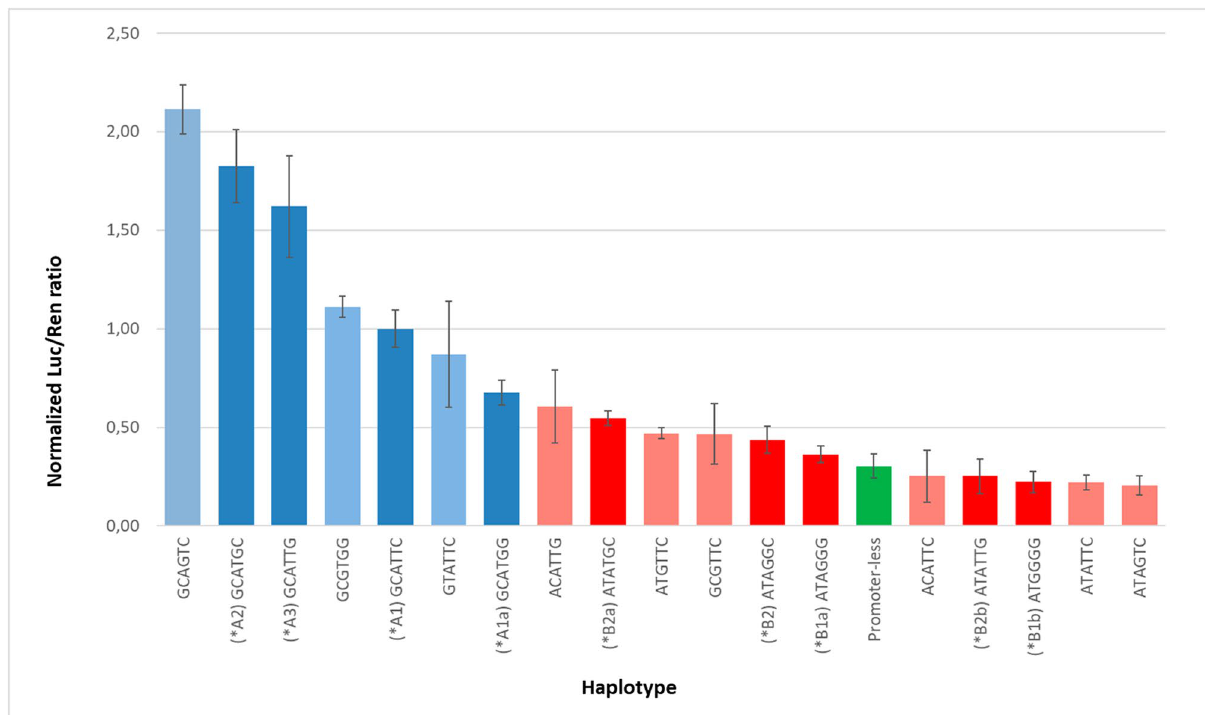
Figure 2. Luciferase reporter assay results for each haplotype. Dark blue (*A haplotypes), dark red (*B haplotypes), faded colours (non-existent haplotypes), green (no